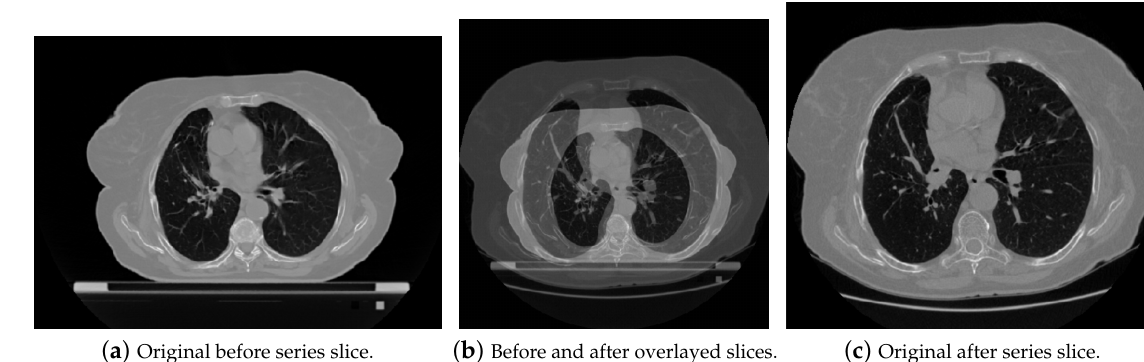
Figure 15. Illustration of the size difference in before and after slices.